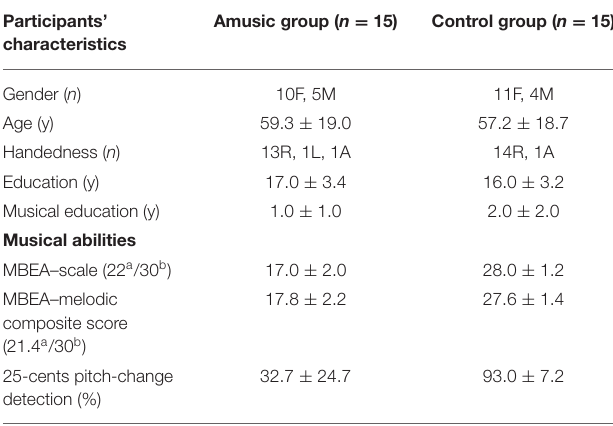
change detection task (Hyde and Peretz,